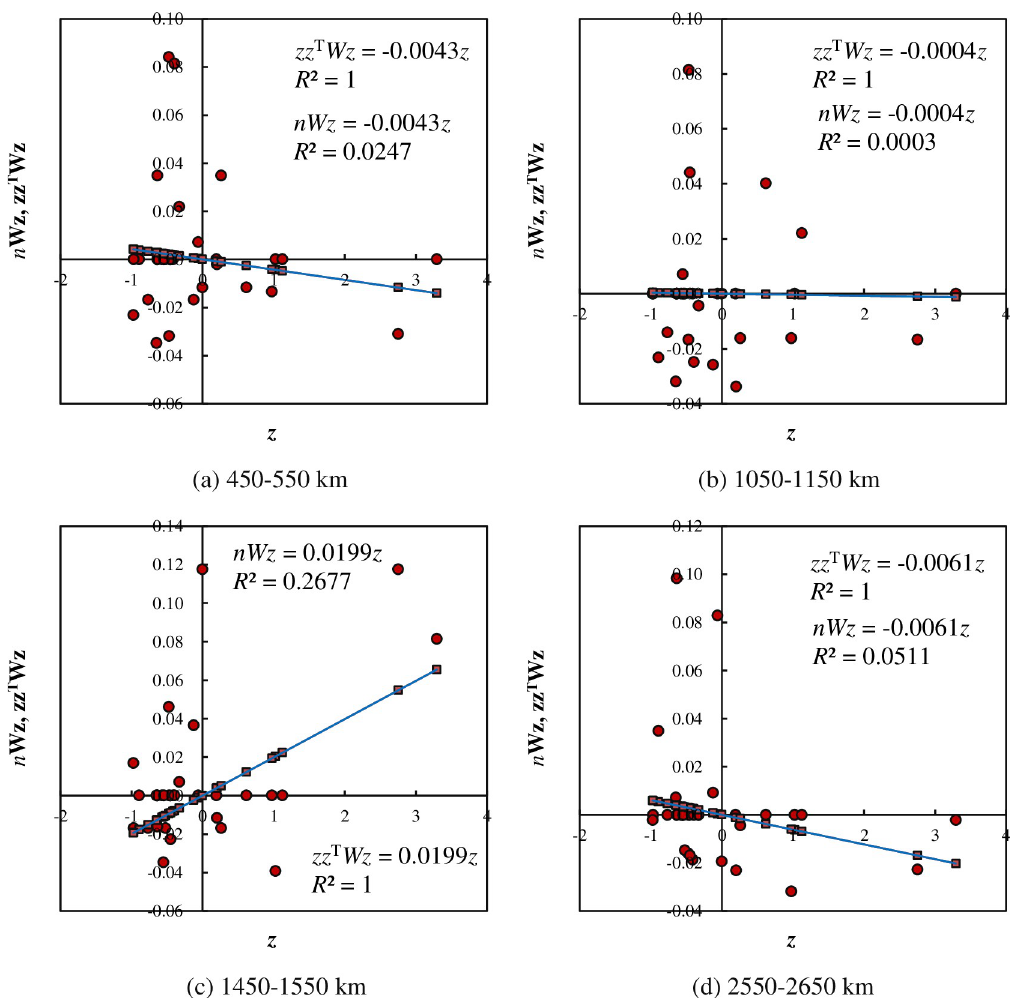
Fig 7. The canonical Moran’s scatterplots of spatial autocorrelation based on correlation density function for the main cities of China (examples for 2010). ( Note : The scatter points are based on the inner product correlation, z T zWz = Iz , and the relation is Eq (14). The trend line is based on the outer product correlation, zz T Wz = Iz , and the relation is Eq (16). The Moran’s index difference values are as follows. (a) For 450 < r � 550, Δ I = -0.0043; (b) For 1050 < r � 1150, Δ I = -0.0004; (c) For 1450 < r � 1550, Δ I = 0.0199; (d) For 2550 < r � 2650, Δ I = 0.0061.).